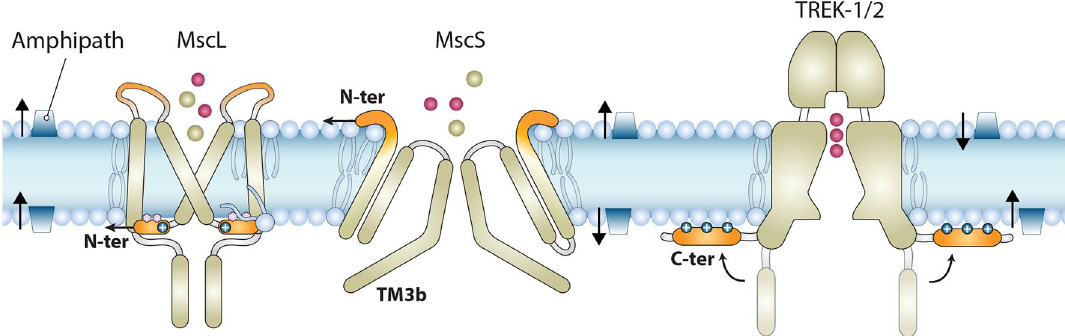
Figure 8. Diagram summarizing the effect of TFE and 5-FU on different types of MS channels. TFE ( ), sensitization ( ), desensitization (